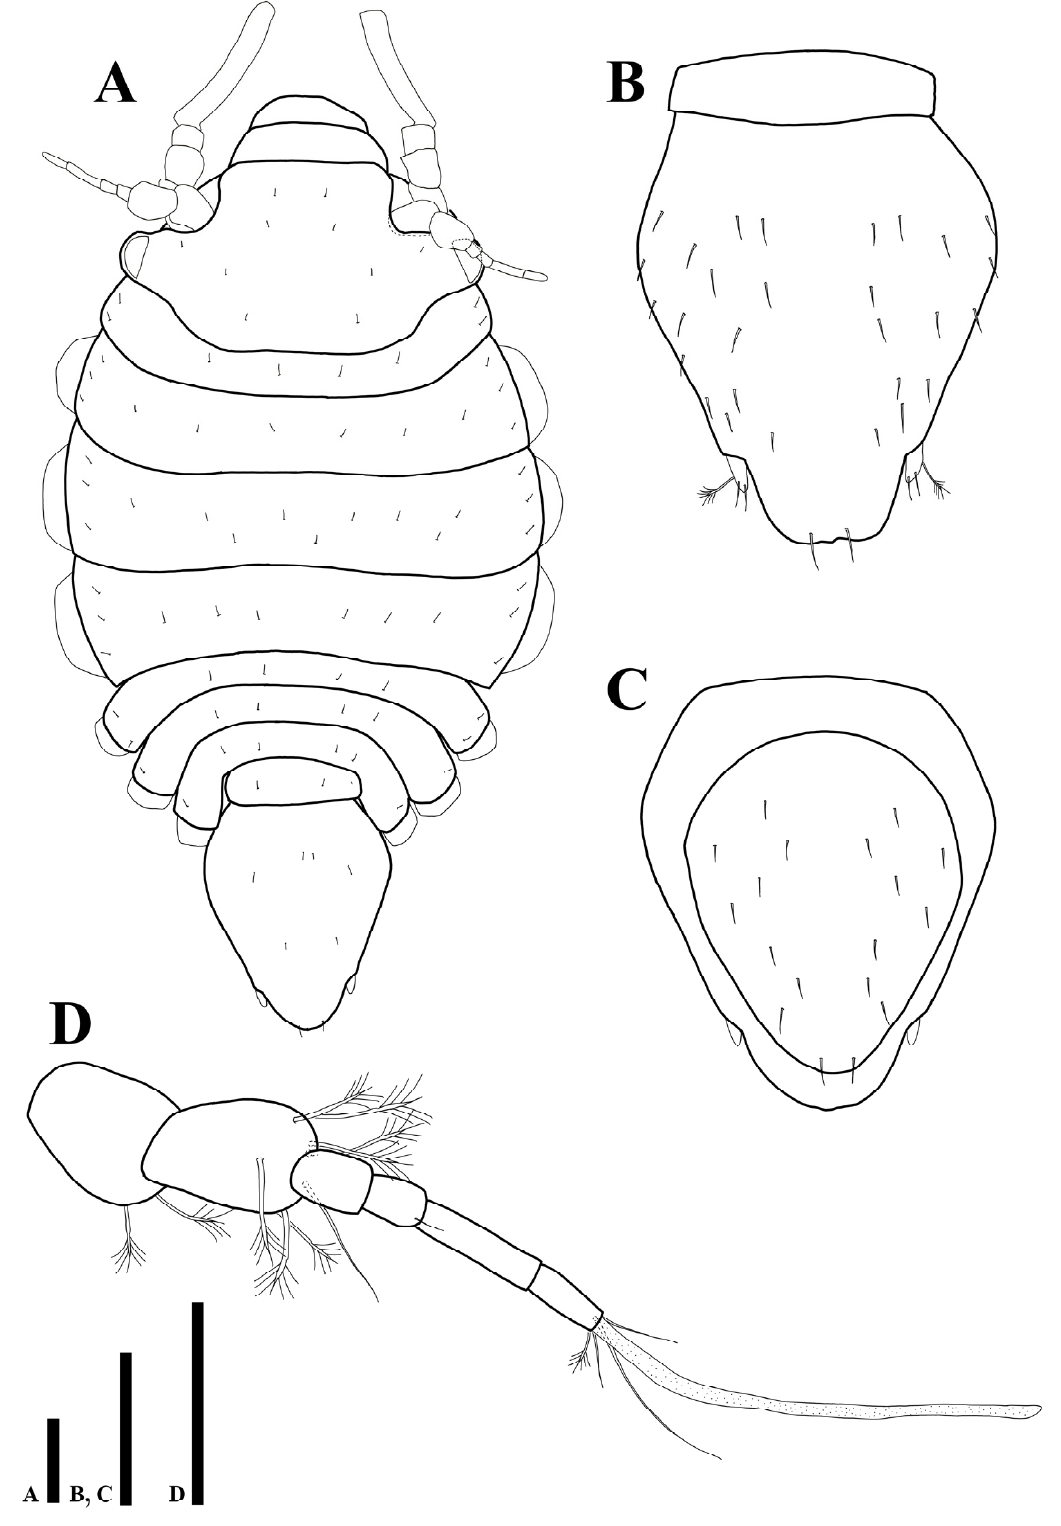
Figure 8. Uromunna mundongensis sp. n. paratype ovigerous female (MABIK CR00252868): ( A ) habitus; ( B ) pleotelson; ( C ) pletelson; ( D ) antennula. Scale bars = 100 µ m ( A – C ), 50 µ m ( D ).